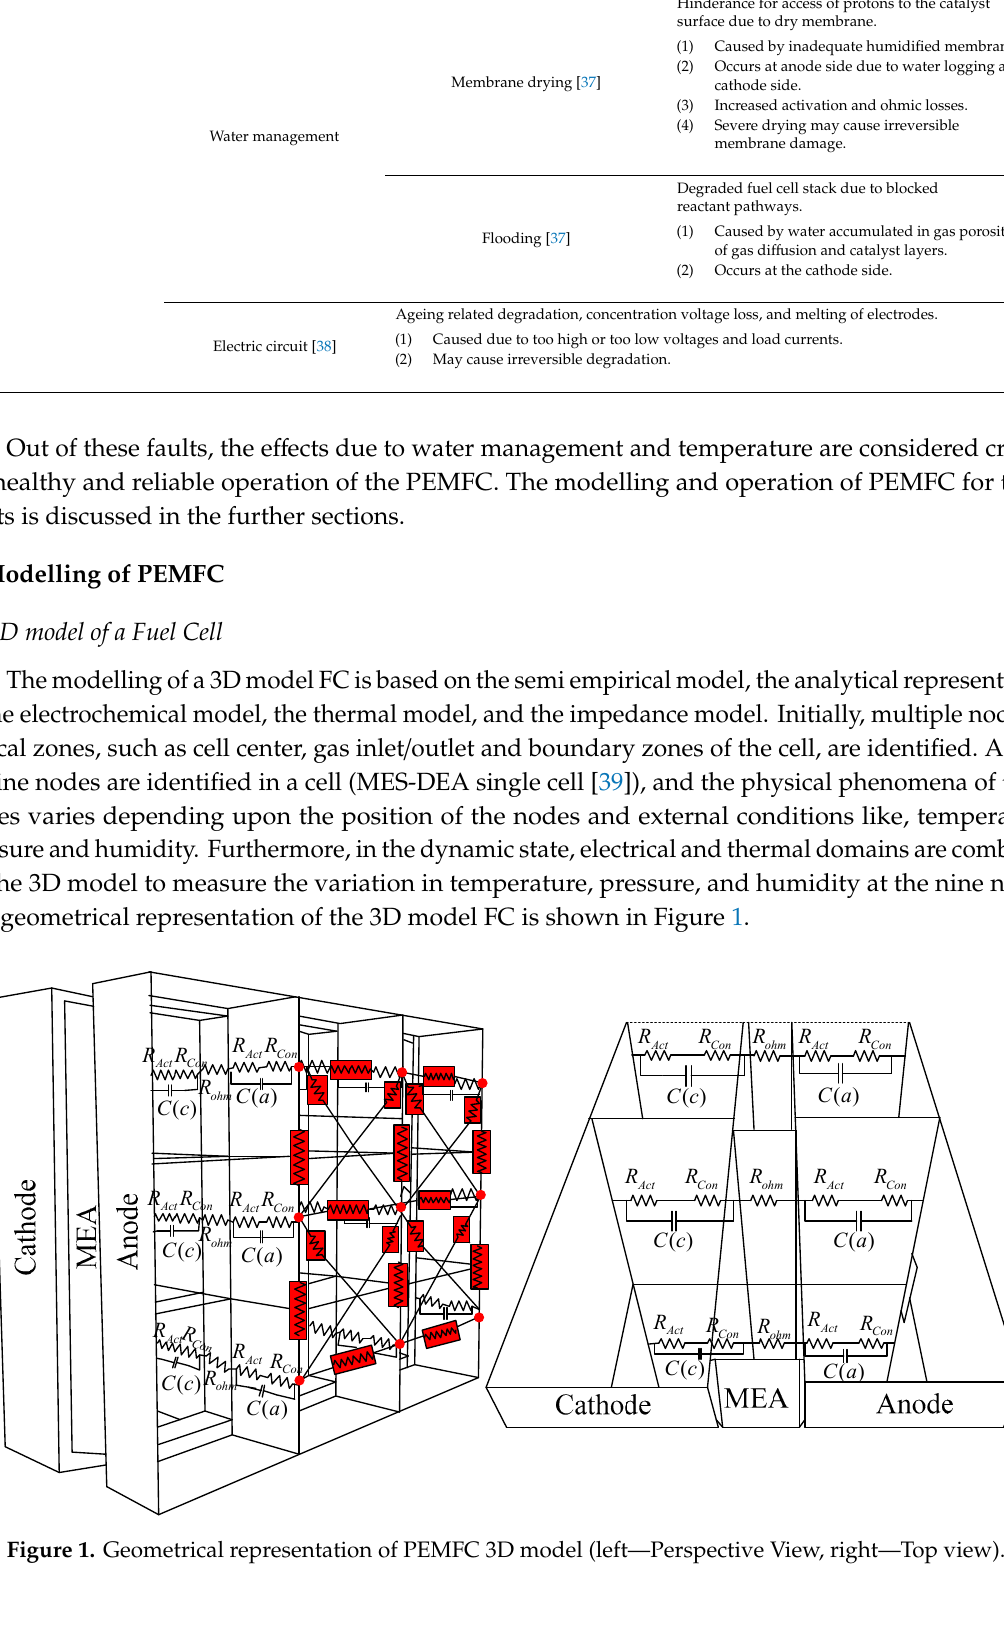
. Figure 2. Dynamic elementary cell mode of PEMFC. The model is based on thermodynamic and electrochemical characteristics, and inputs the temperature impact ((cid:1846)) , hydrogen pressure (cid:1842) (cid:3009) (cid:3118) and oxygen pressure (cid:1842) (cid:3016) (cid:3118) , voltage Nernst, and other (activation, ohmic, and concentration) losses [7,40]. This is mathematically given by: (cid:1831) (cid:3030)(cid:3032)(cid:3039)(cid:3039)((cid:3021),(cid:3017)) = (cid:1831) (cid:2868) − 0.000845((cid:1846) − 273.15) + 0.00431(cid:1846) ln(cid:3435)(cid:1842) (cid:3009) (cid:3118) (cid:1842) (cid:2868) (cid:3118) (cid:2868).(cid:2873) (cid:3439)